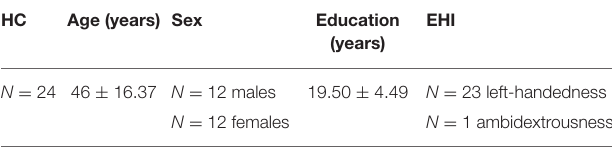
TABLE 2 | Demographic features of healthy control